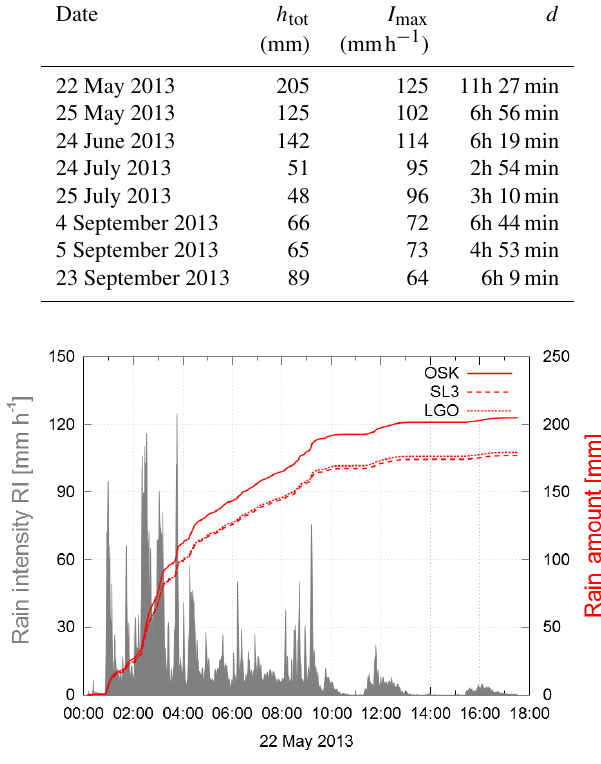
Figure 3. Reference rainfall intensity measured by the OSK drop counter (shaded grey background) and comparison of the accu- mulated reference (red continuous line) with the accumulated Lo- gotronic (LGO) and Shanghai (SL3) measurements during the sam- ple event of 22 May 2013.